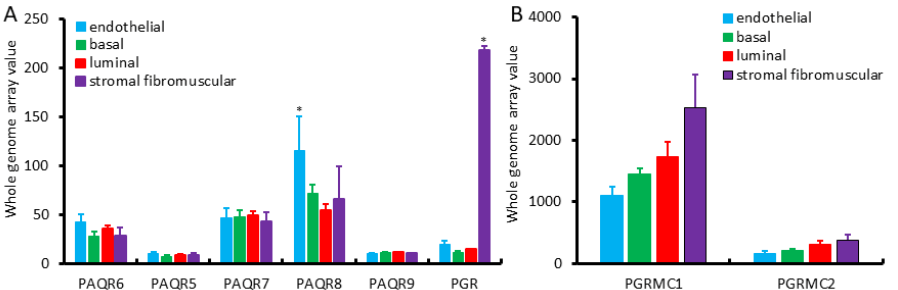
Figure 1. ( A , B ) Expression pattern of PAQR genes in different prostate cell types, including basal, luminal secretory, stromal fibromuscular, and endothelial cells of the prostate, as described in a previous report [19]. Cell types were separated with antibody-based magnetic cell sorting (MACS) against distinct cell-type-specific cluster designation (CD) antigens. Gene expression levels